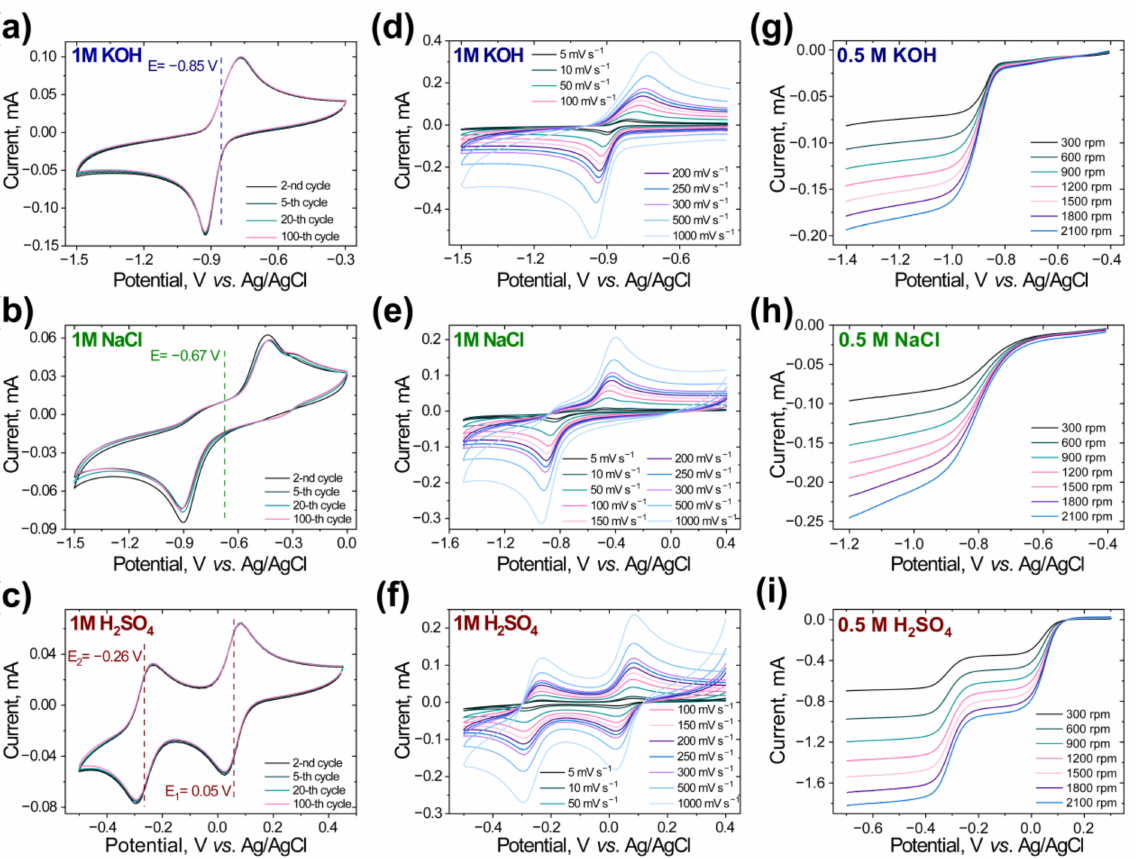
Figure 2. Multiple CVs of 30 mM aqueous solutions of M1 with ( a ) 1.0 M KOH, ( b ) 1.0 M NaCl, and ( c ) 1.0 M H 2 SO 4 SEs at a scan rate of 100 mV s − 1 . CVs under different scan rates for 30 mM aqueous solution of M1 with ( d ) 1.0 M KOH, ( e ) 1.0 M NaCl, and ( f ) 1.0 M H 2 SO 4 SE. Linear sweep voltammetry tests with a glassy carbon rotating disk electrode for M1 in ( g ) 0.5 M KOH, ( h ) 0.5 M NaCl, and ( i ) 0.5 M H 2 SO 4 as a SE at a scan rate of 10 mV s − 1